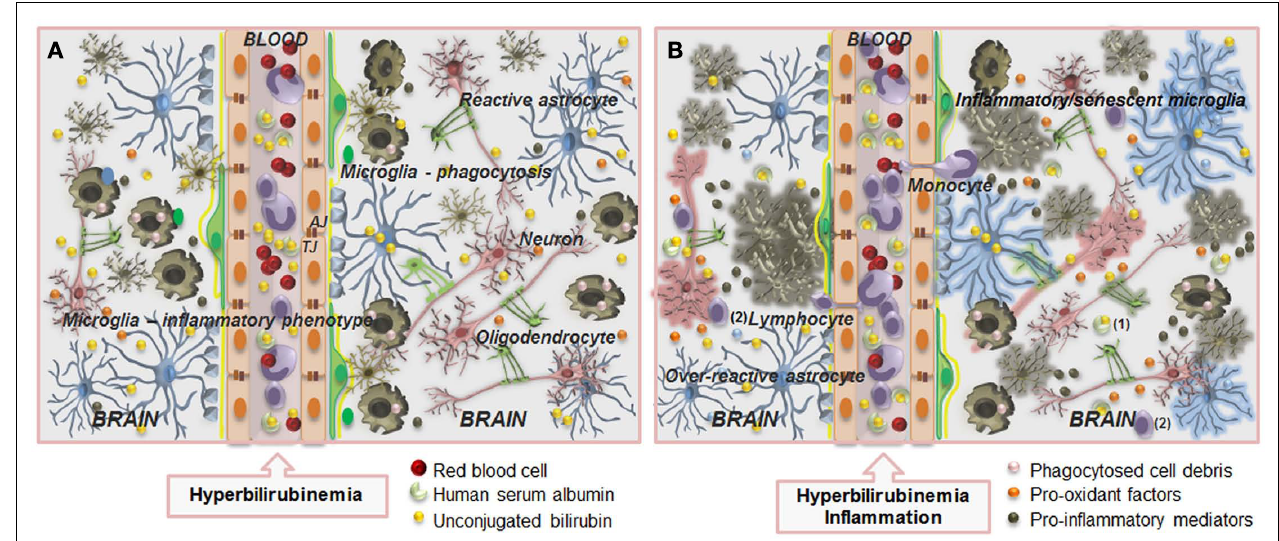
oligodendrocytes (solid-green) is also observed. (B) When sepsis is associated to hyperbilirubinemia, increased alterations at structural and functional levels are produced. Endothelial cell and astrocyte end-feet degeneration, modified basement membrane composition, tight junction, phenotypes and both neurons and oligodendrocytes will degenerate.Thus, therapeutic strategies directed at controlling the activation of microglia and astrocytes, and the excessive production of pro-inflammatory mediators and pro-oxidant factors may add on the prevention and recovery of neurologic sequelae resulting from unconjugated